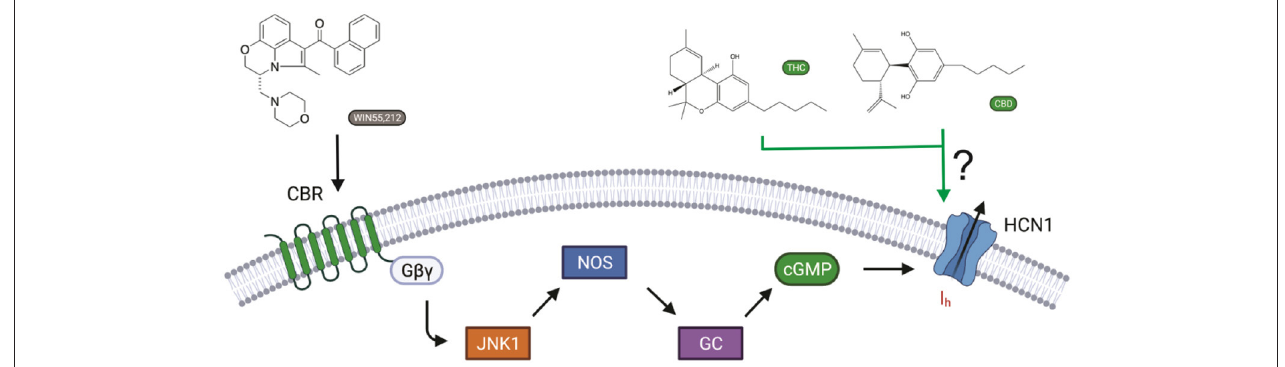
FIGURE 1 | Cannabinoid regulation of I h in neurons. The synthetic cannabinoid WIN55,212-2 affects memory via increasing I h by activating CB1 receptors, leading to JNK-mediated increases in activated nitric oxide synthase (NOS), resulting in increased guanylyl cyclase activity and, in turn, cGMP (Hill et al., 2012). However, cannabinoids have also been shown to modify the function of several ion channels independently of cannabinoid receptors (CBRs) activation. Here, we ask if hyperpolarization-activated cyclic-nucleotide-gated (HCN1) channels can be directly modulated by cannabidiol (CBD) and 1 9-tetrahydrocannabinol (THC) (Maroso et al.,